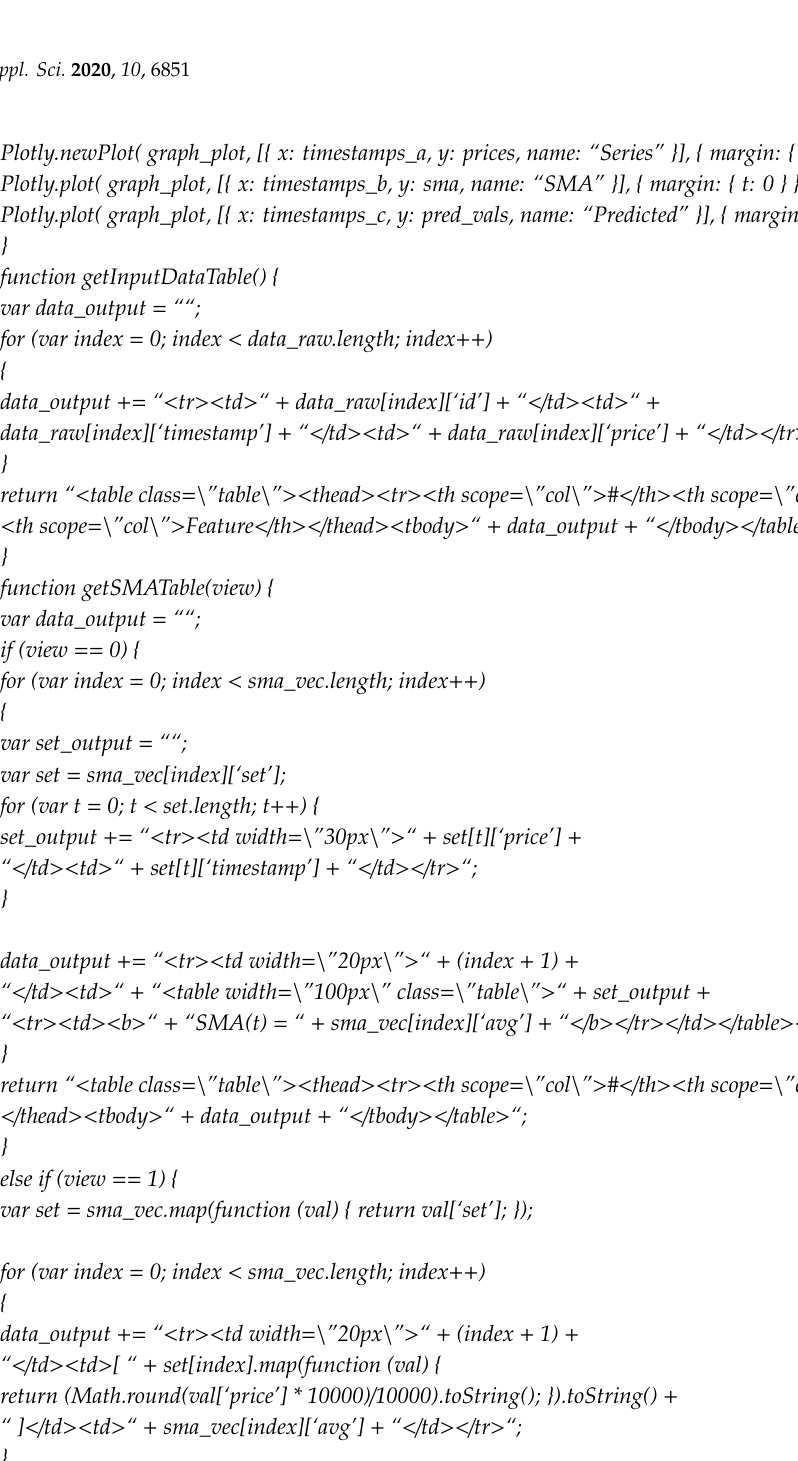
Plotly.newPlot( graph_plot, [{ x: timestamps_a, y: prices, name: “Series” }], { margin: { t: 0 } } ); Plotly.plot( graph_plot, [{ x: timestamps_b, y: sma, name: “SMA” }], { margin: { t: 0 } } ); Plotly.plot( graph_plot, [{ x: timestamps_c, y: pred_vals, name: “Predicted” }], { margin: { t: 0 } }